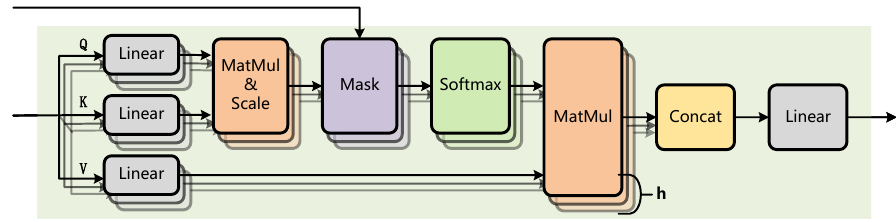
Figure 3. Illustration of the masked